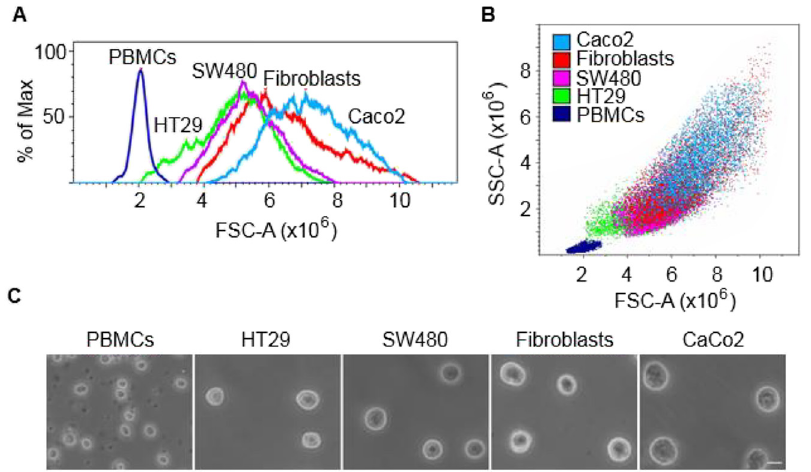
Figure 4: Morphological differences between cell types. (A) and (B) Flow cytometry plots showing forward (FSC) and side (SSC) scatter of colorectal cancer cells (CaCo2, SW480, HT29) and normal primary cells (skin fibroblasts, PBMCs). (C) Phase contrast microscopy images of the different cell types in suspension. Scale bar: 10 μ